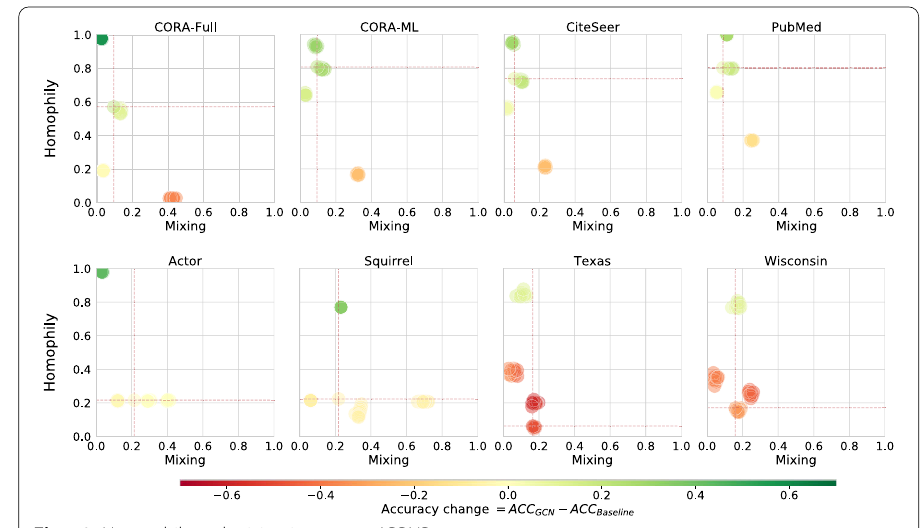
Fig. 12 Homophily and mixing impact on APPNP accuracy